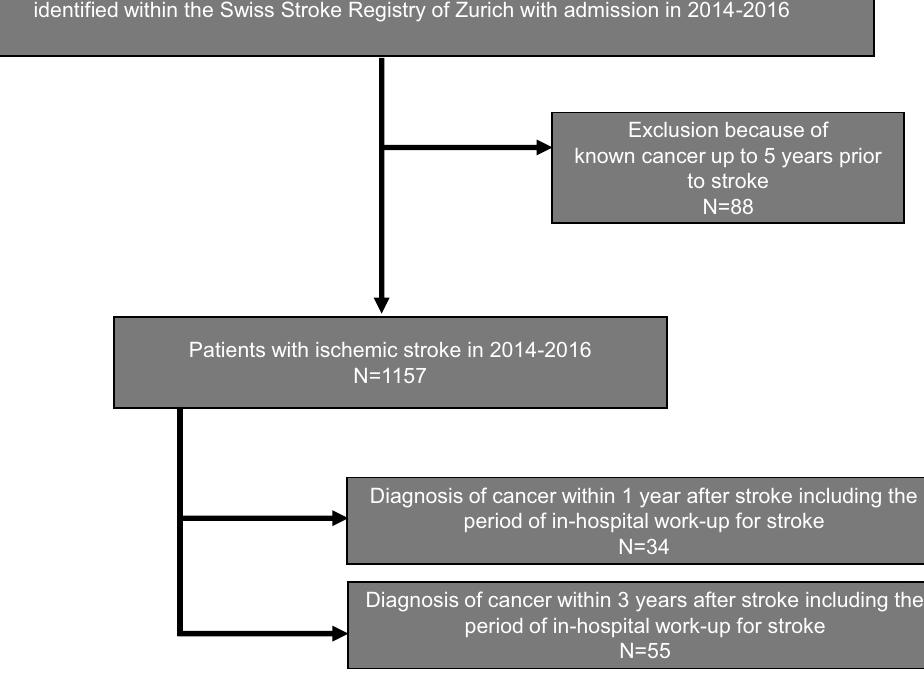
Figure 1. Consort chart. Process of patient identification for the study